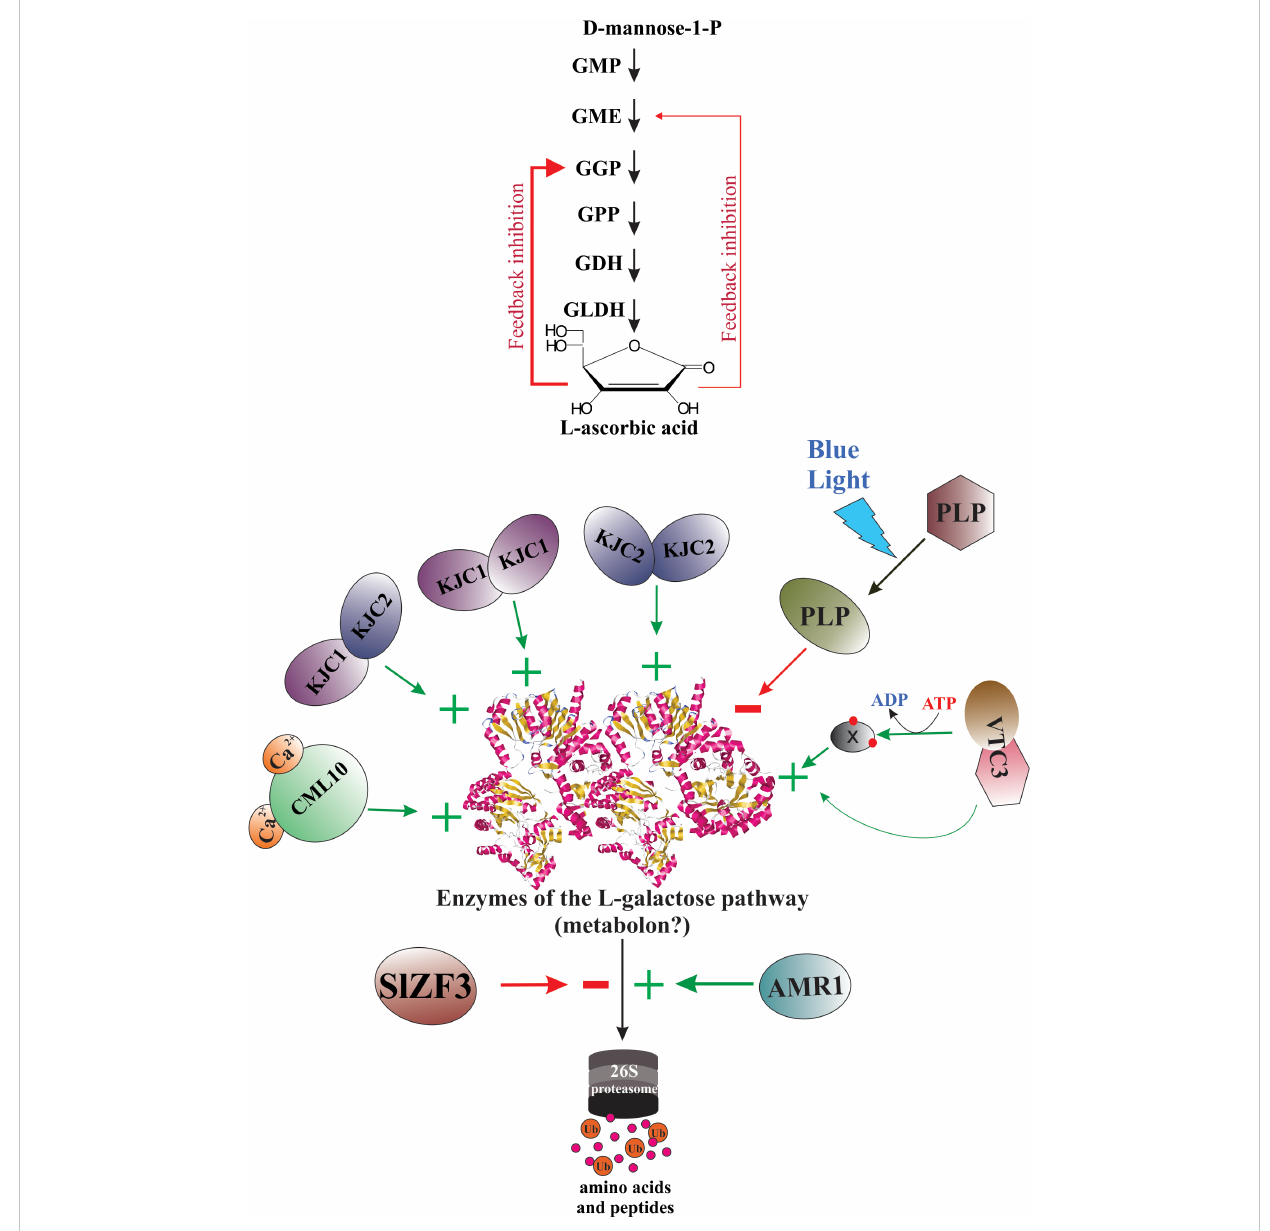
FIGURE 5 Biochemical strategies for regulation of AsA biosynthesis in plants. In plants, several biochemical mechanisms have been described, including control of the enzyme levels, control of the enzyme catalytic activity, feedback inhibition of regulatory enzymes, and other